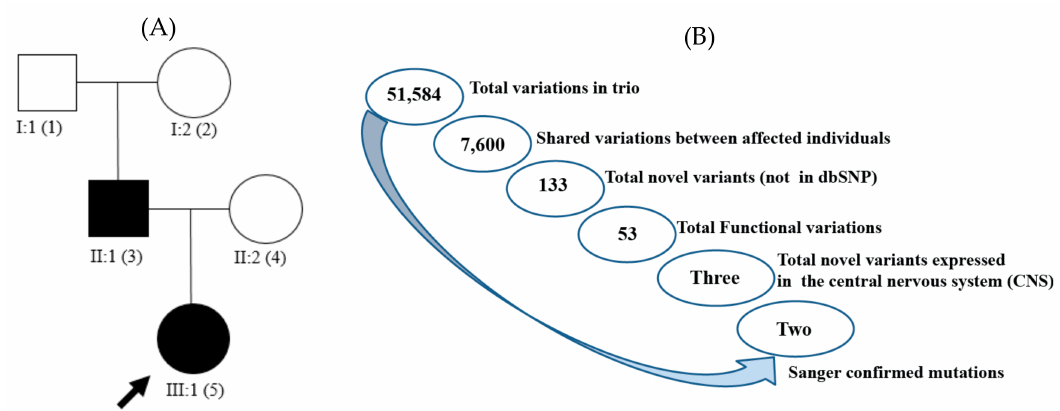
Figure 3. ( A ) Family tree of two affected individuals with episodic ataxia. Squares represent men; circles, women; black filled figures, affected EA; unfilled figures, unaffected; arrow represents our proband; ( B ) schematic representation of the variant filtering. Total variant counts at each stage of filtering using Ion Reporter software resulted in two non-synonymous novel variants, in the affected individuals, of genes expressed in the central nervous system and confirmed with Sanger sequencing